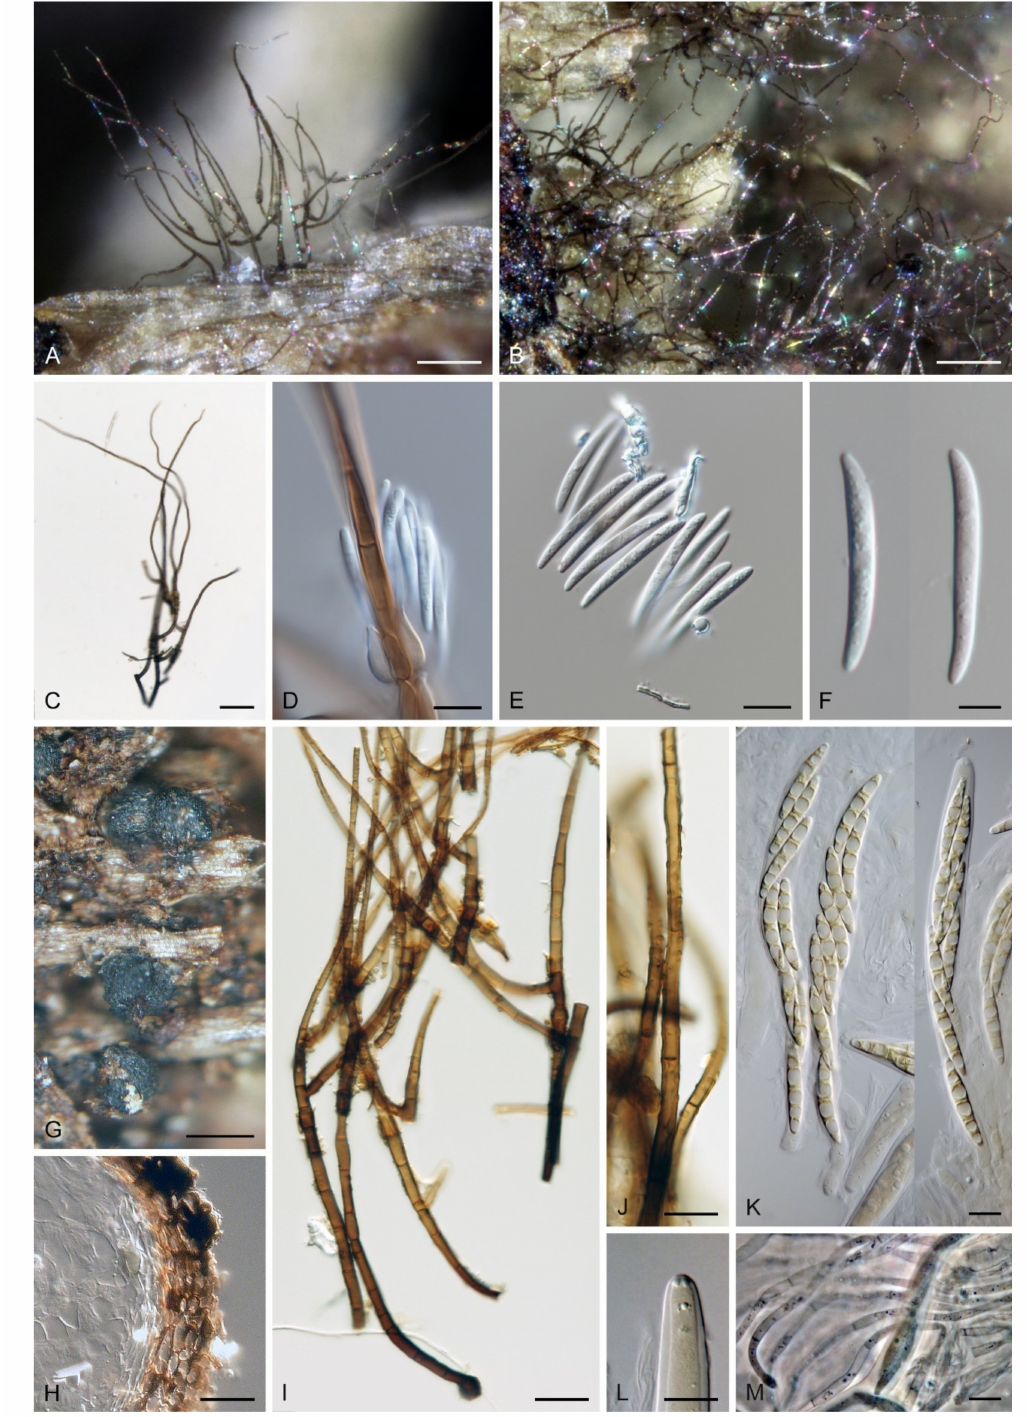
Figure 15. Zanclospora novae-zelandiae . ( A – C , I ) Conidiophores. ( D ) Phialides with conidia. ( E , F ) Conidia. ( G ) Ascomata. ( H ) Vertical section of the ascomal wall. ( J ) Anastomosing conidiophores with excrescences, in detail. ( K ) Asci. ( L ) Ascal apex. ( M ) Paraphyses. Images: ( A – M ) on the natural substrate; ( A – F ) from PDD 20737 (holotype); ( G – M ) from ICMP 15112. Bars: ( A , B ) = 100 µ m; ( C ) = 50 µ m; ( D , E , J – M ) = 10 µ m; ( F ) = 5 µ m; ( G ) = 250 µ m; ( H ) = 20 µ m; ( I ) = 25 µ